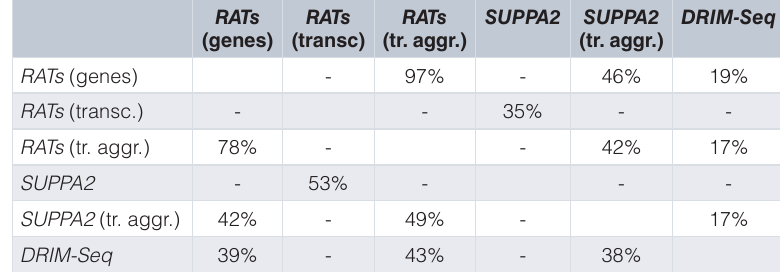
Table 3. Summary of DTU features (genes or transcripts) detected by each method. DRIM-Seq reports DTU only at the gene level. SUPPA2 reports DTU only at the individual transcript level. RATs reports at both the transcript and the gene levels, using its respective test implementations. For SUPPA2 and the transcript-level approach in RATs , gene-level results can be inferred from the reported transcripts; these are included in the table, enclosed in parentheses. The last two columns show the reproducibility of the results between annotation versions. DTU: Differential transcript usage.